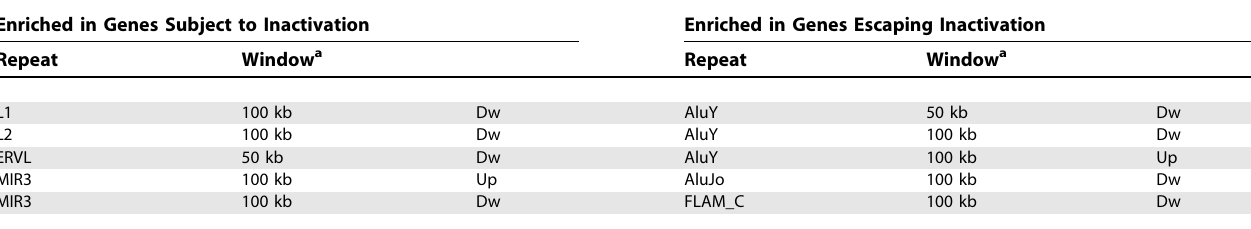
Table 1. Repeat Features Whose Distributions are Significantly Different in All Three Evolutionary Stratifications when Comparing Genomic Environments of Genes Subject to and That Escape Inactivation Enriched in Genes Subject to